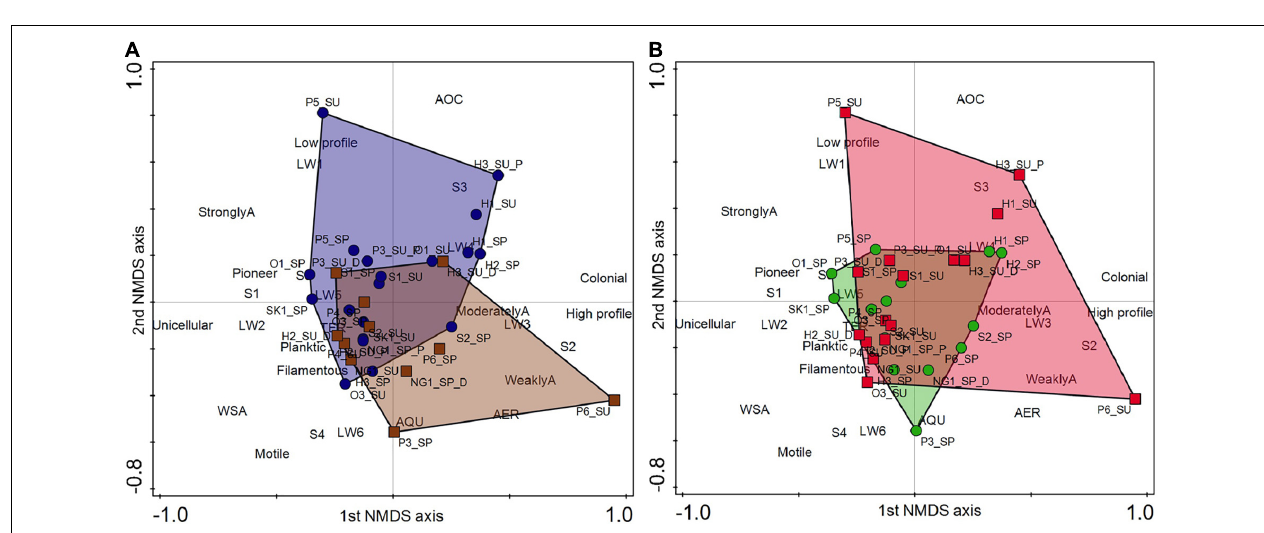
FIGURE 3 | Results of the trait-based Non-metric Multi-dimensional Scaling (NMDS) analysis of the mean trait profiles of diatom assemblages. Trait categories and their abbreviations are found in Table 1 . (A) Dry phase is marked with brown squares (their covered area is brown). Aquatic phase is marked with blue circles (their covered area is blue). (B) Spring period is marked with green circles (their covered area is green). Summer period is marked with red squares (their covered area is